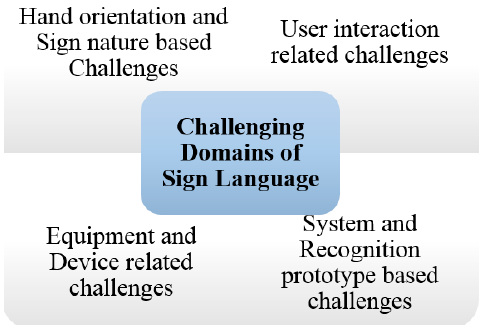
Figure 19. Challenging domains of sign language.